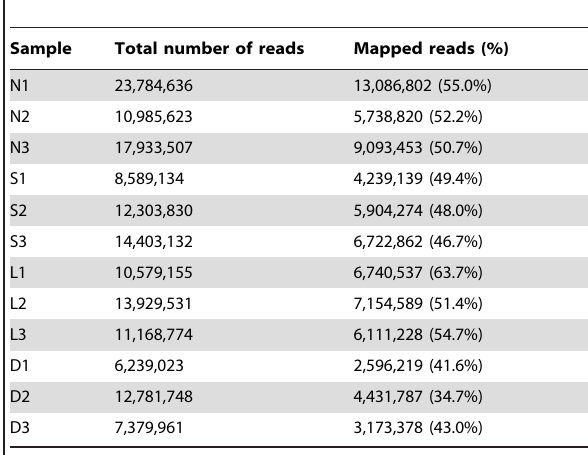
Table 3. Total number of sequencing reads obtained per animal and the number of the reads mapped and the corresponding